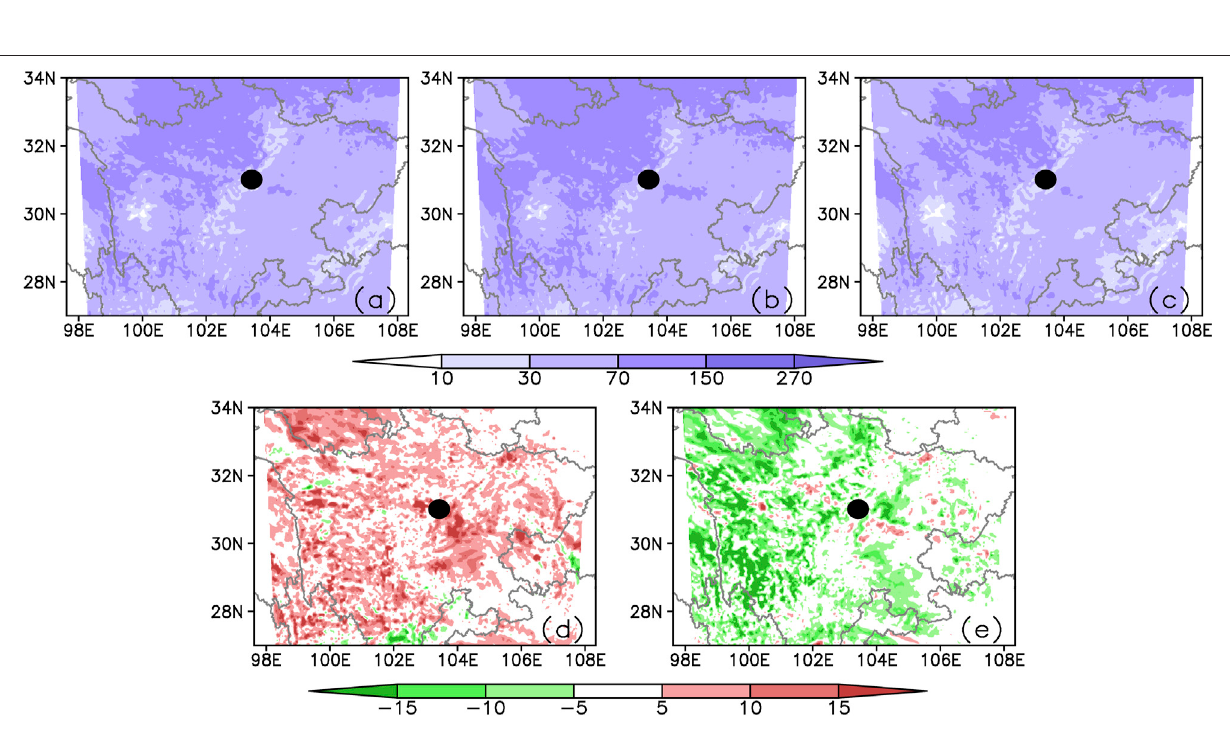
Frontiers in Earth Science |